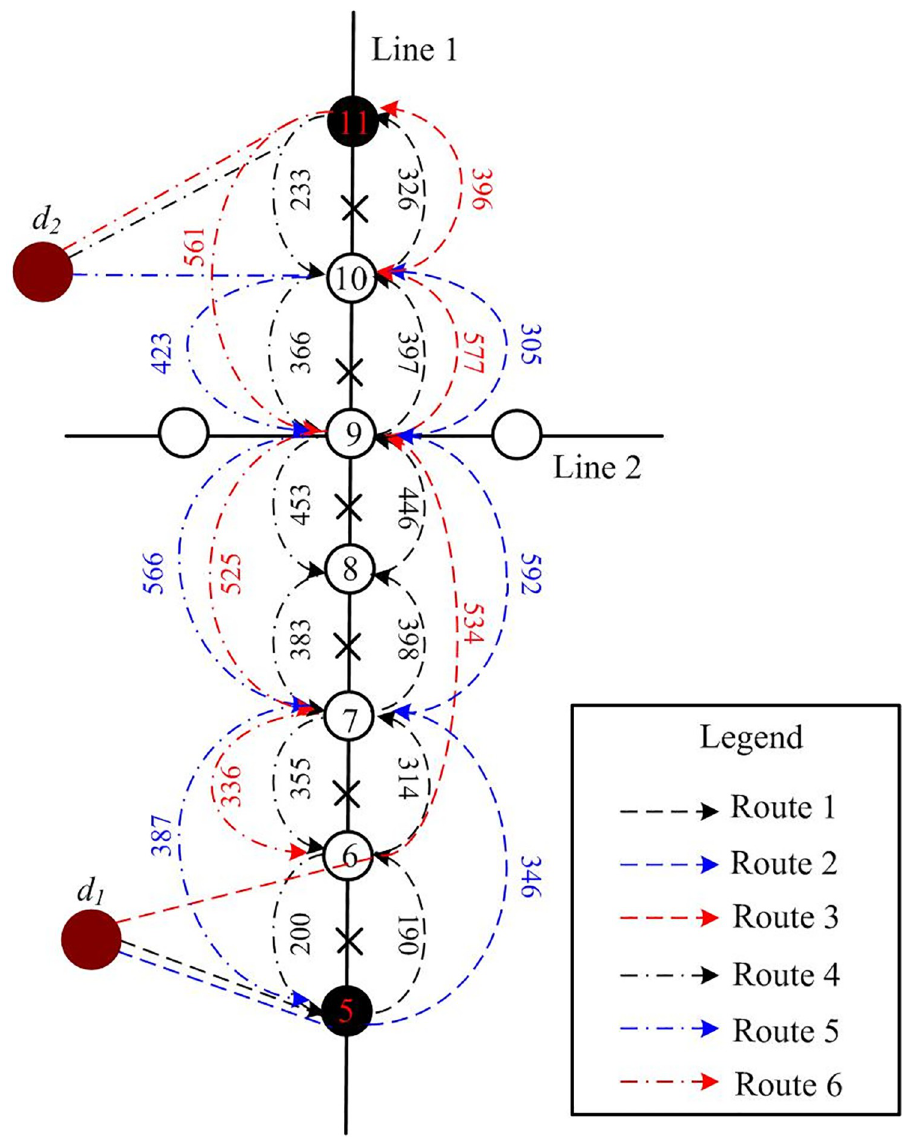
Fig 5. The candidate bridging-bus routes in scenario.